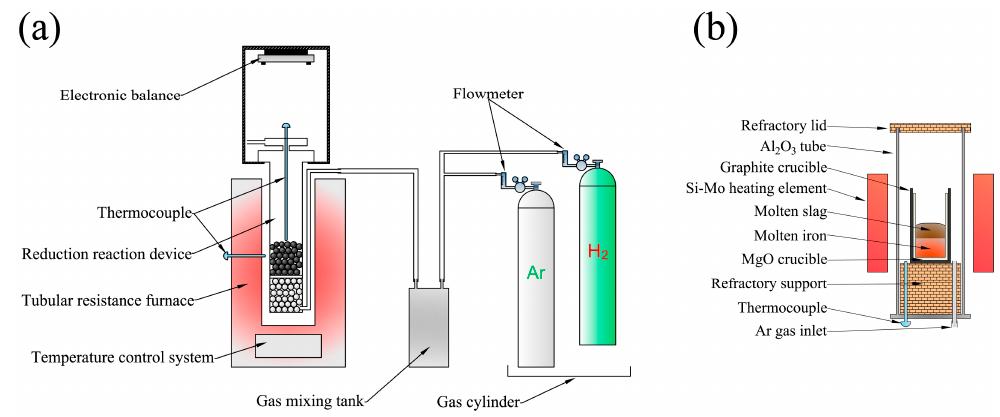
Figure 1. ( a ) The experimental apparatus employed for reduction of iron ore pellets and ( b ) Si-Mo resistance furnace employed to carry out the separating and refining process.